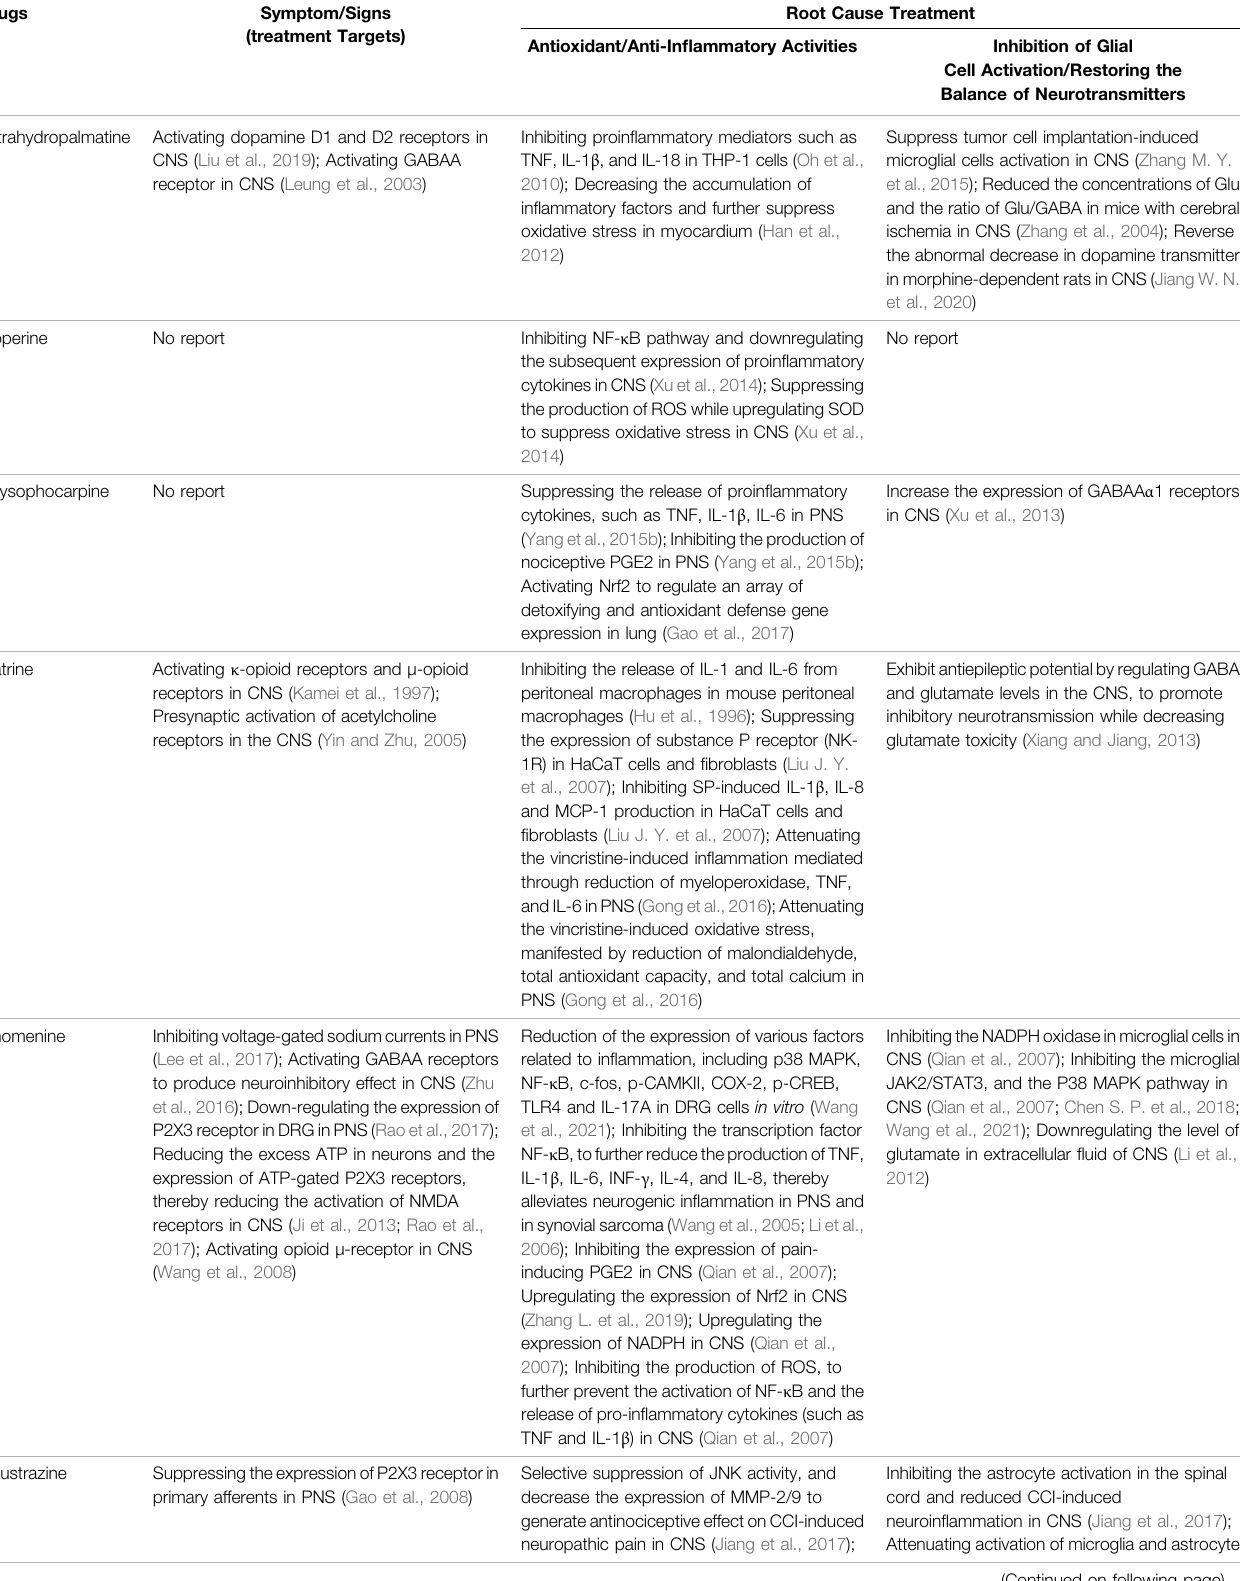
TABLE 2 | Mechanism similarity between TCM derived analgesic